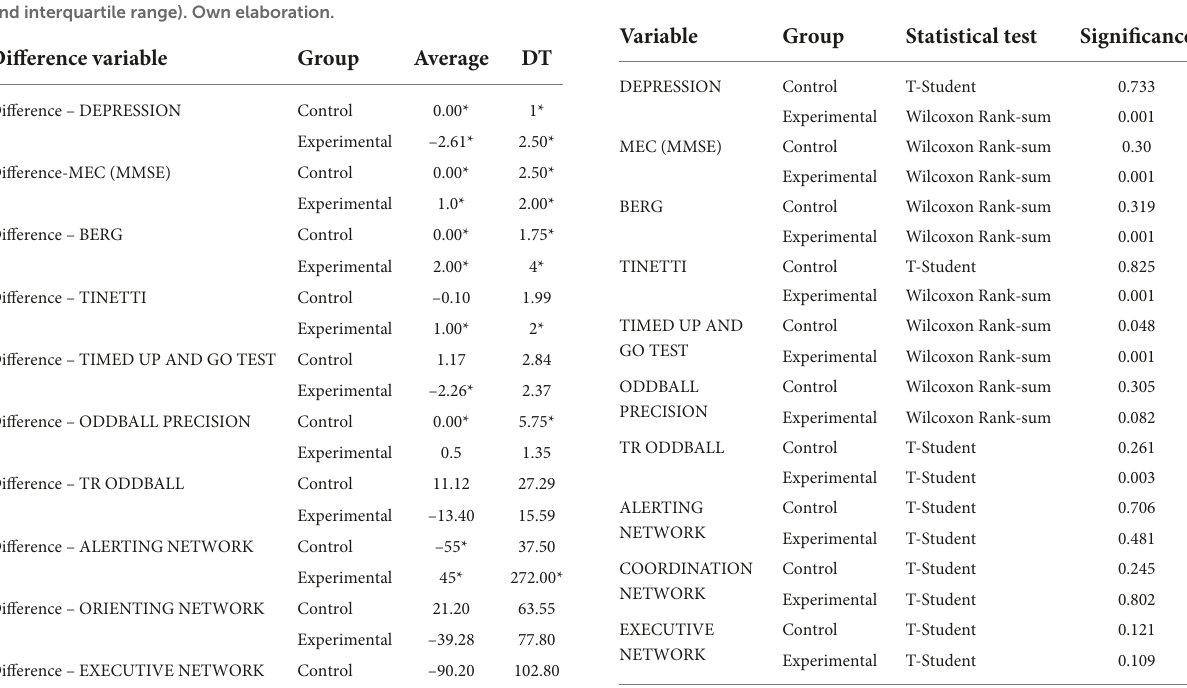
TABLE 4 Contrast tests in the groups. Reference: own